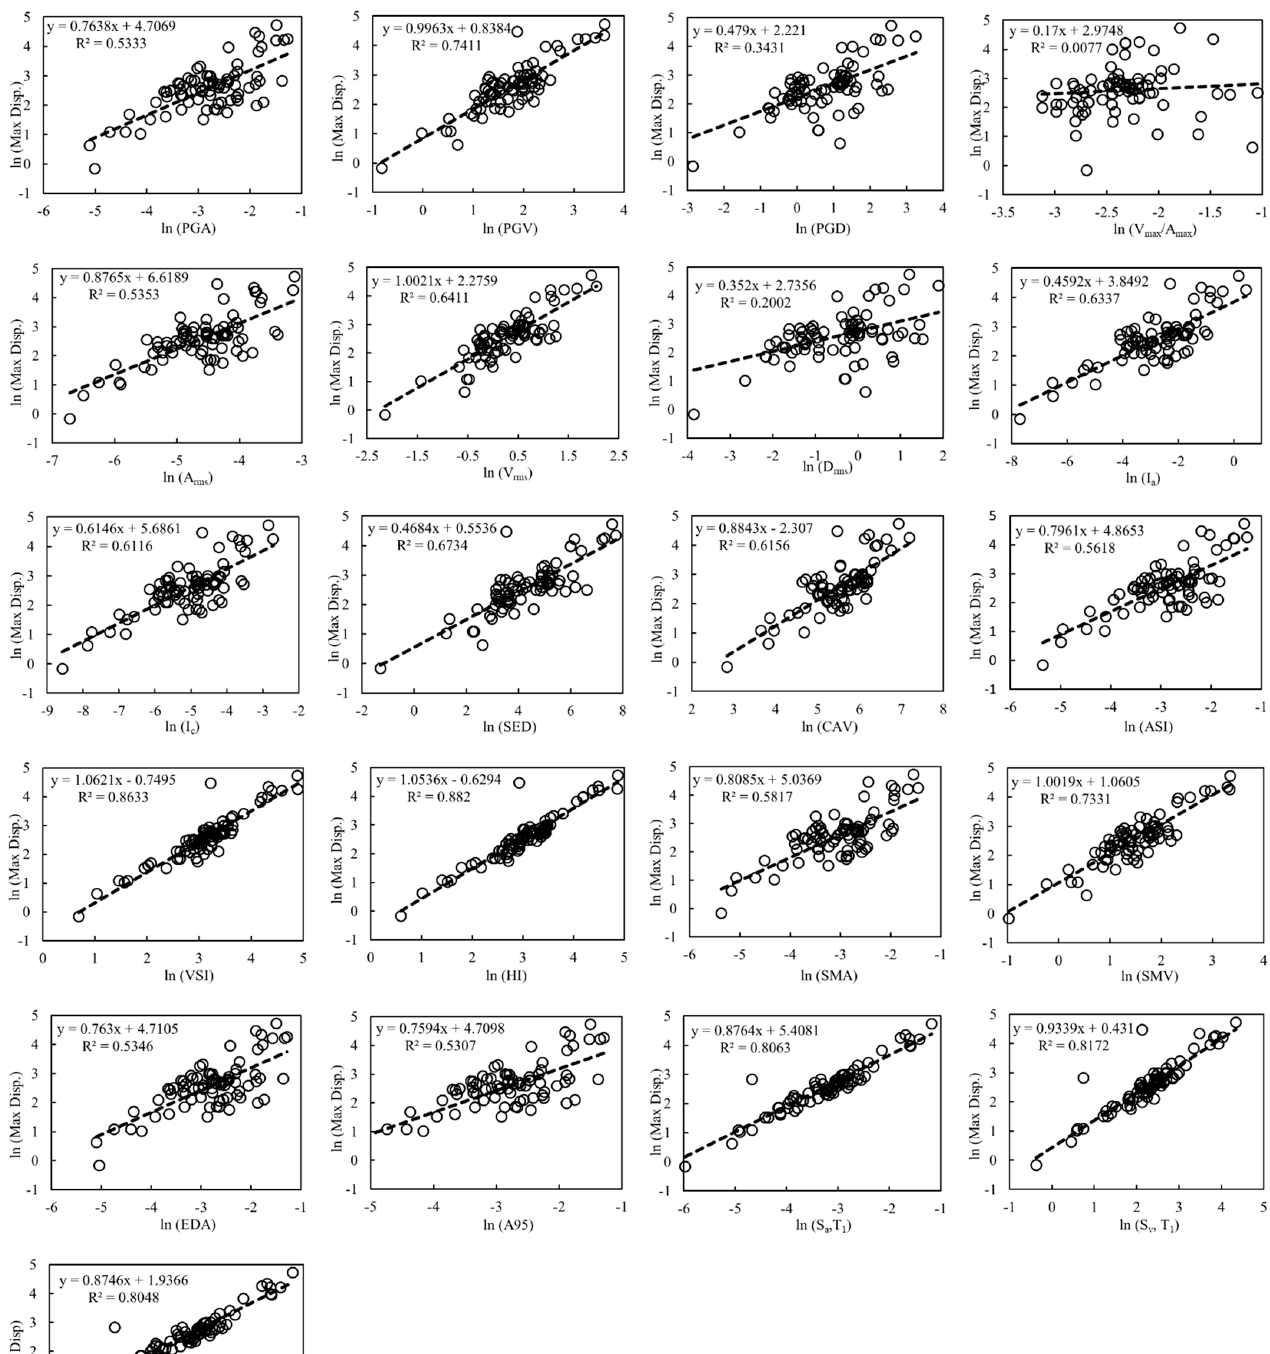
Figure 11. Linear regression of PSDMs for various IMs considering maximum displacement as EDP.